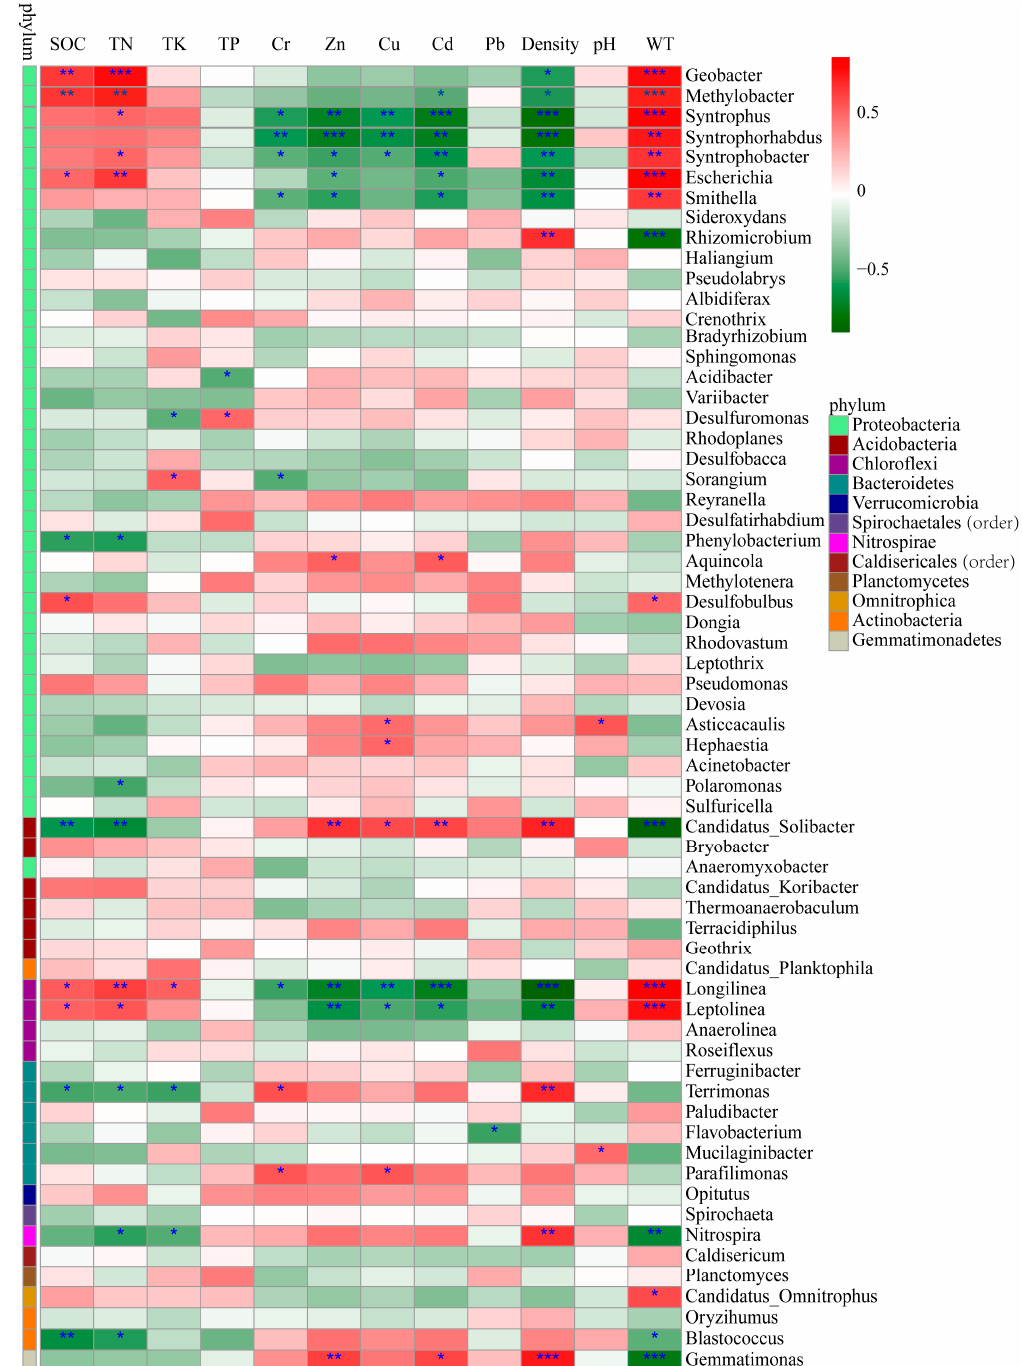
Figure 7. Pearson correlation heat map with correlation coefficient and significance levels based on the bacterial abundance and environmental factors. Colors from green to red represent negative to positive. * indicates significance test p < 0.05; ** indicates significance test p < 0.01; *** indicates significance test p < 0.001.